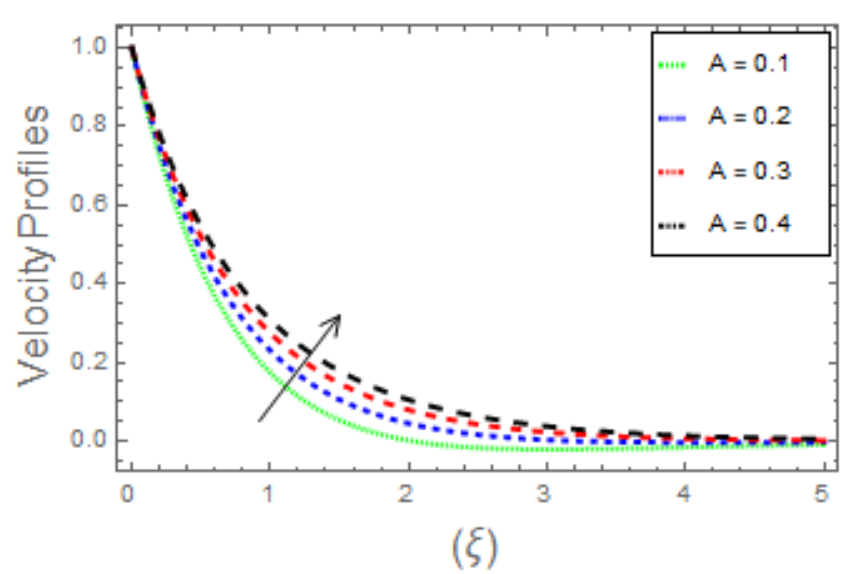
Figure 4. Variation in T due to M .